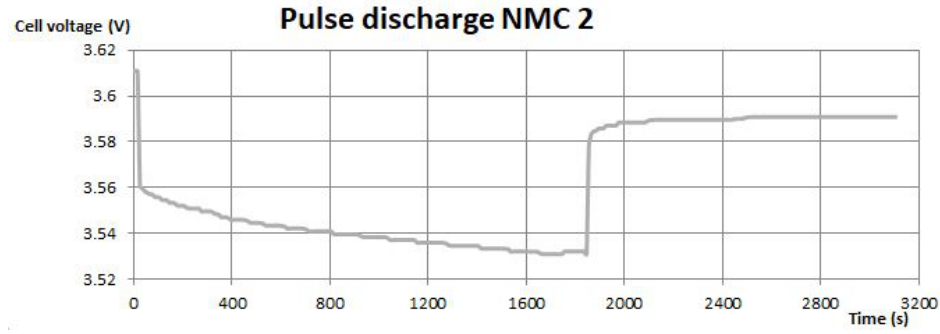
Figure 4. Dependency between the voltage of the NMC2 cell and time during pulse discharge